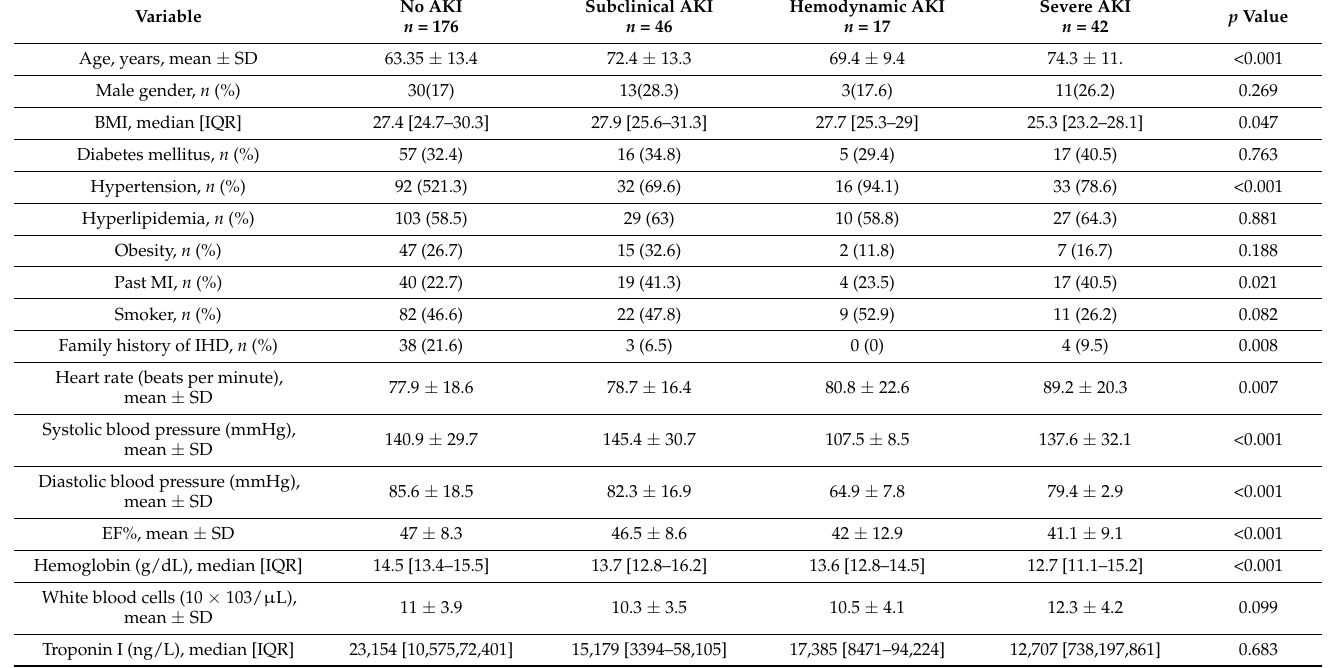
Table 1. Baseline characteristics of 281 STEMI patients based on AKI